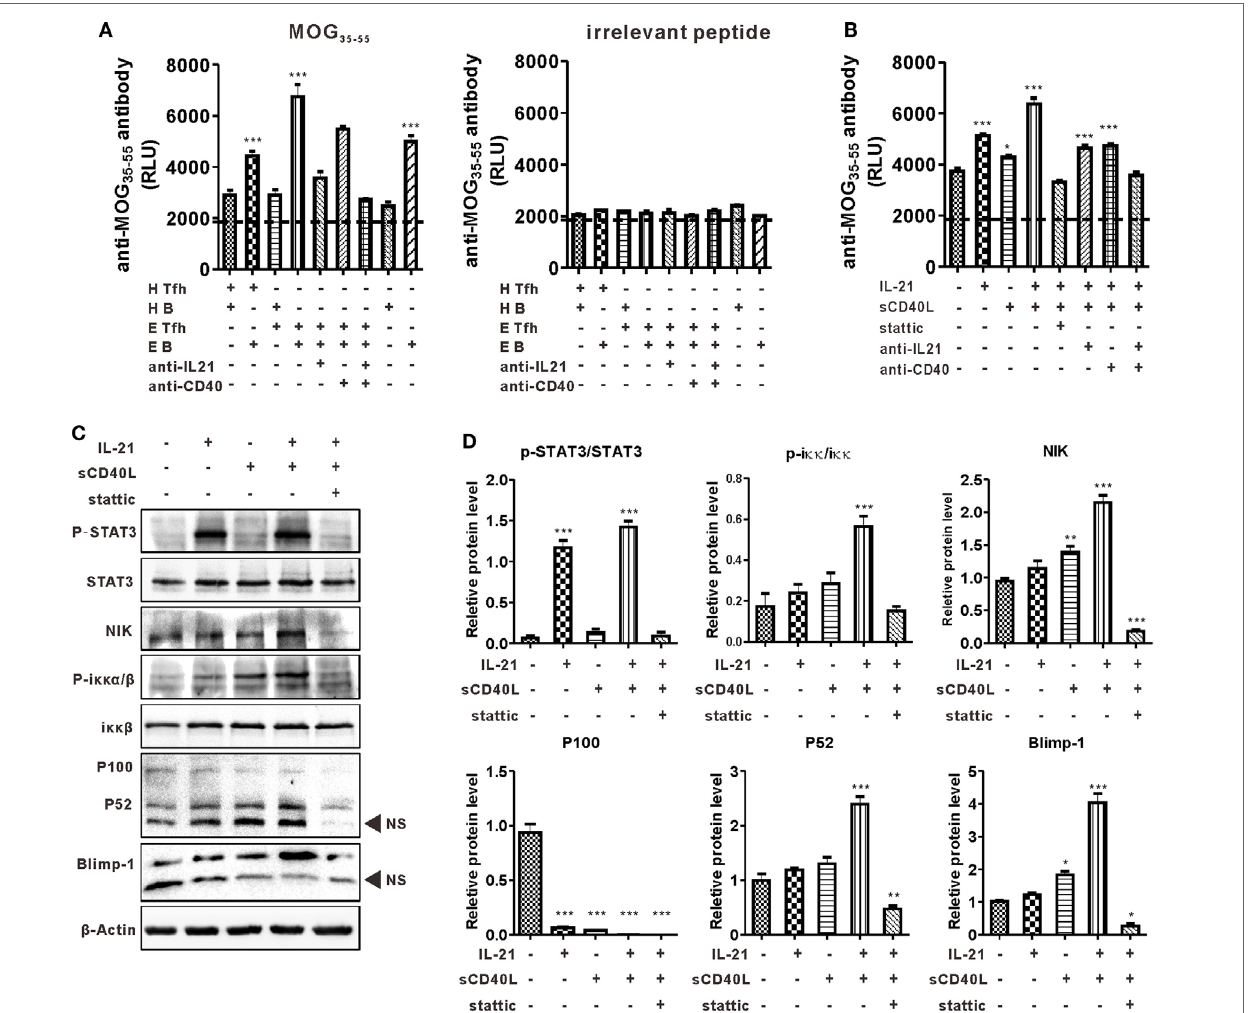
FigUre 5 | T follicular helper (Tfh)-like cells help B cells product autoantibody in an IL-21 and CD40 ligand (CD40L)-dependent manner. (a) Tfh-like and B cells from healthy controls (HCs) and experimental autoimmune encephalomyelitis (EAE) mice were cocultured. The level of anti-MOG 35–55 antibodies were measured by chemiluminescent enzyme-linked immunosorbent assay (CLISA) in the supernatant of Tfh/B coculturing system. H Tfh-like and H B stand for Tfh-like from HCs and B cells from HCs, respectively. E Tfh-like and E B stand for Tfh-like from EAE mice and B cells from EAE mice, respectively. *** P < 0.001 vs. the first lane. (B) Sorted B cells from EAE mice were stimulated with MOG 35–55 and relevant cytokines or inhibitors for 7 days. The levels of anti-MOG 35–55 antibodies in the supernatant were measured by CLISA. * P < 0.05, *** P < 0.001 vs. the first lane. (c) Sorted B cells from EAE mice were subjected to the indicated culture conditions. Cells were stimulated for 3 h and then lysed for western blotting analysis to detect the level of the indicated protein markers except B lymphocyte- induced maturation protein-1 (Blimp-1). For Blimp-1, B cells were cultured for 48 h and then prepared for western blotting analysis. NS, nonspecific band. (D) Statistical data of the relative protein level. Data were shown as mean ± SEM. * P < 0.05, ** P < 0.01, *** P < 0.001 vs. the first lane. Results are representative of three independent